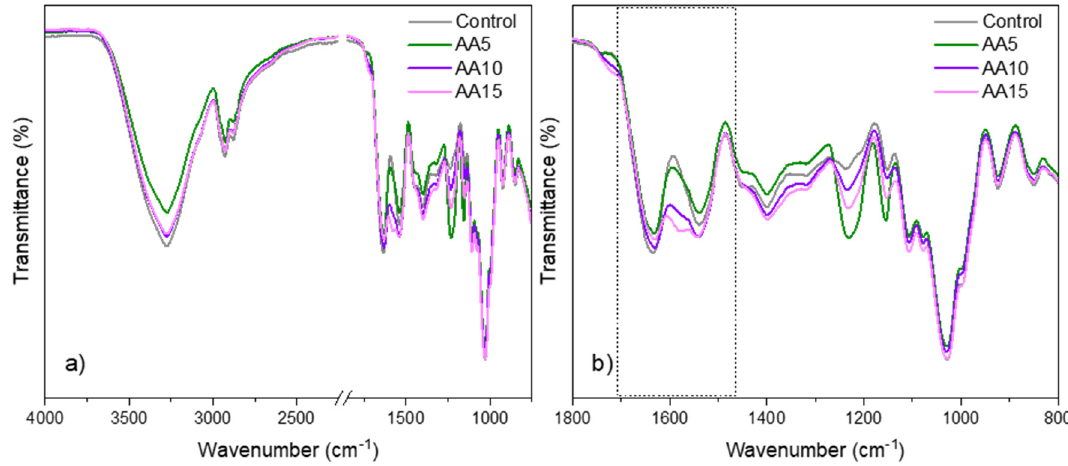
Figure 1. FTIR spectra of WPI films as a function of ascorbic acid (AA) content: ( a ) full spectra from 4000 to 800 cm − 1 and ( b ) zoom in between 1800 and 800 cm − 1 .